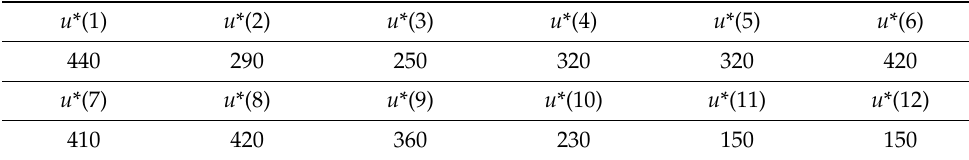
Table 8. Economical production plan.